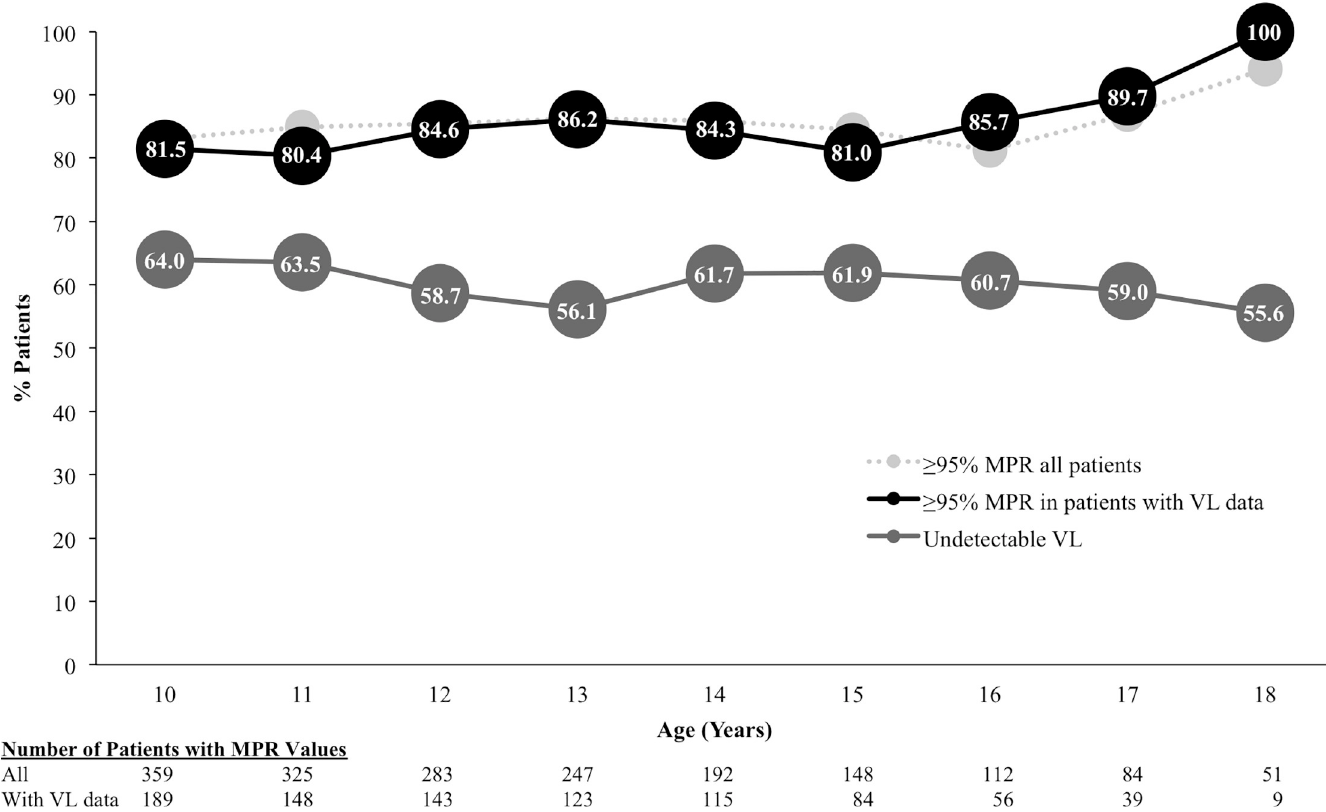
Fig 3. Adherence as measured by MPR and VL during adolescent years by age cohorts. MPR, medication possession ratio; VL, viral load.